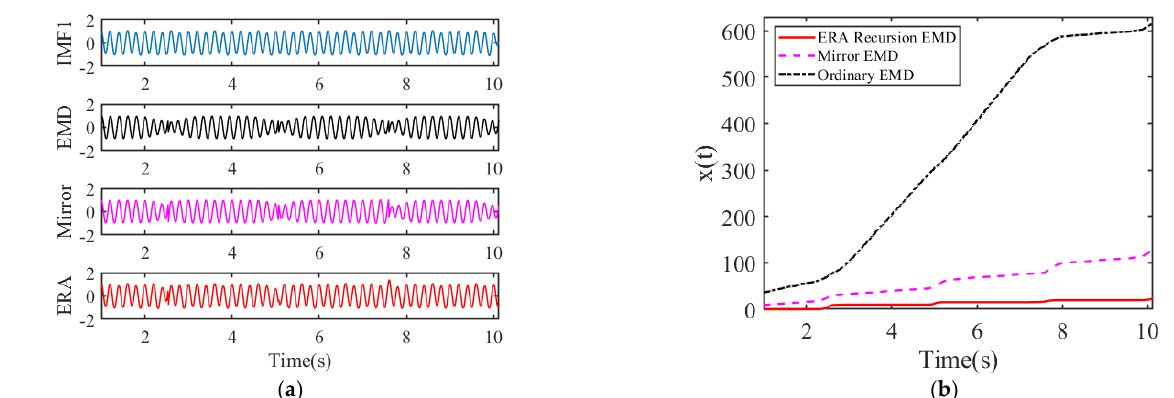
8 of 24 Table 1. Error statistics for different signal conditions. Signal